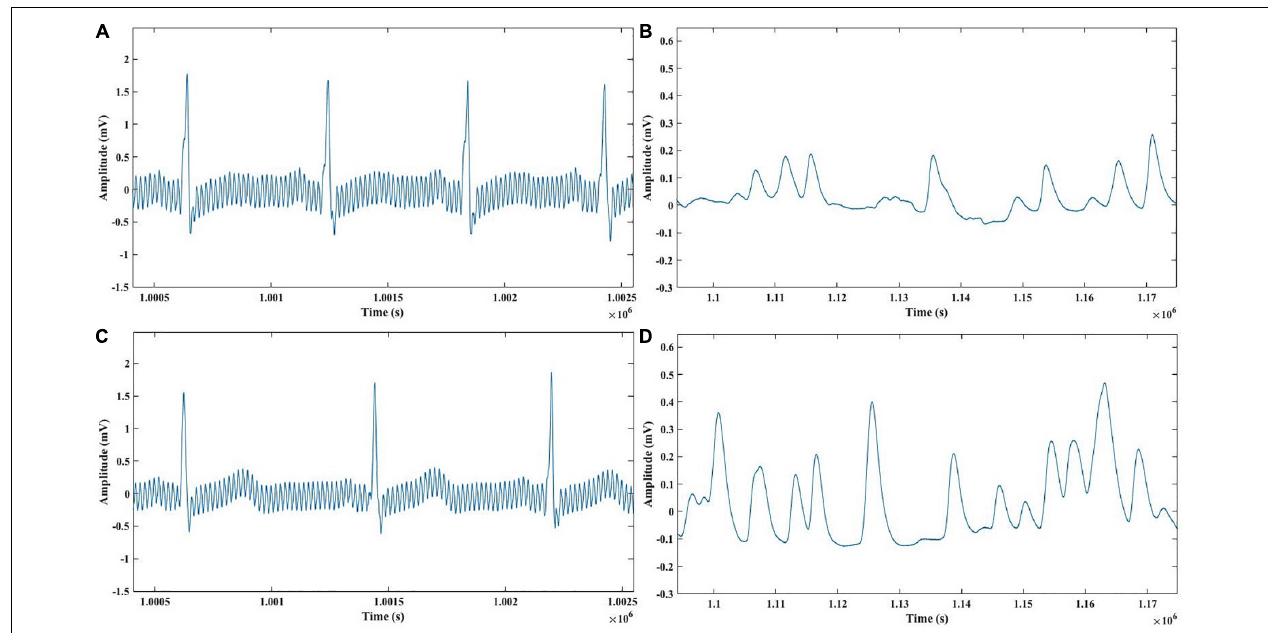
FIGURE 3 | (A) Raw ECG signals of a participant in the Control condition during questioning period. (B) Raw GSR signals of a participant in the Control condition during questioning period. (C) Raw ECG signals of a participant in the Drug condition during questioning period. (D) Raw GSR signals of a participant in the Drug condition during questioning period.